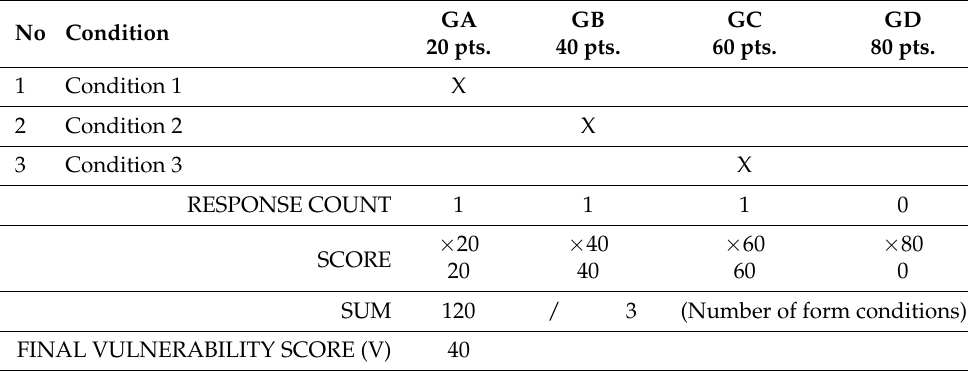
Table 4. Example of scoring modifier evaluation for each GV.